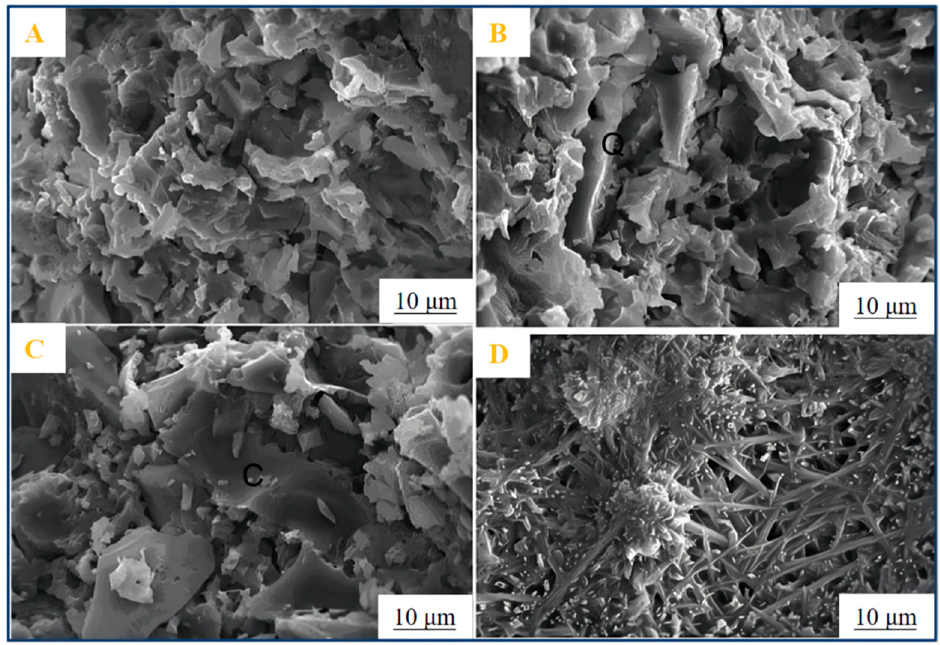
Figure 6. SEM images of geopolymers heated for 1 h at various temperatures ( A )—150 °C, ( B )— 1050 °C, ( C )—1450 °C, ( D )—1550 °C [18]. ( B )—1050 ◦ C, ( C )—1450 ◦ C, ( D )—1550 ◦ C